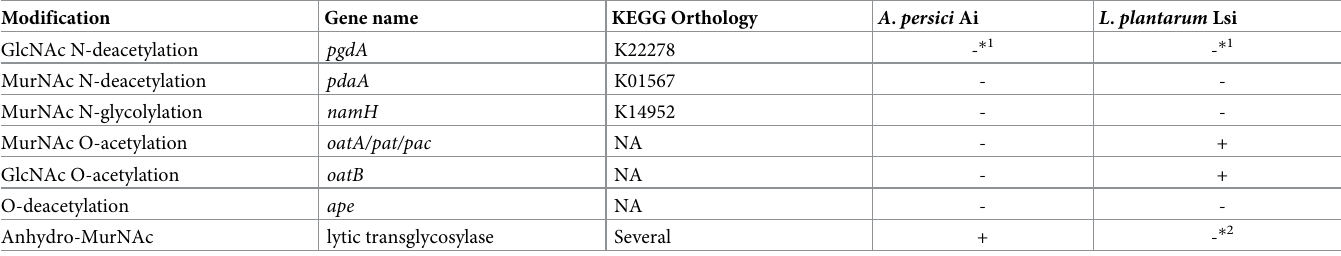
Table 1. Genes related to peptidoglycan modifications in the bacterial